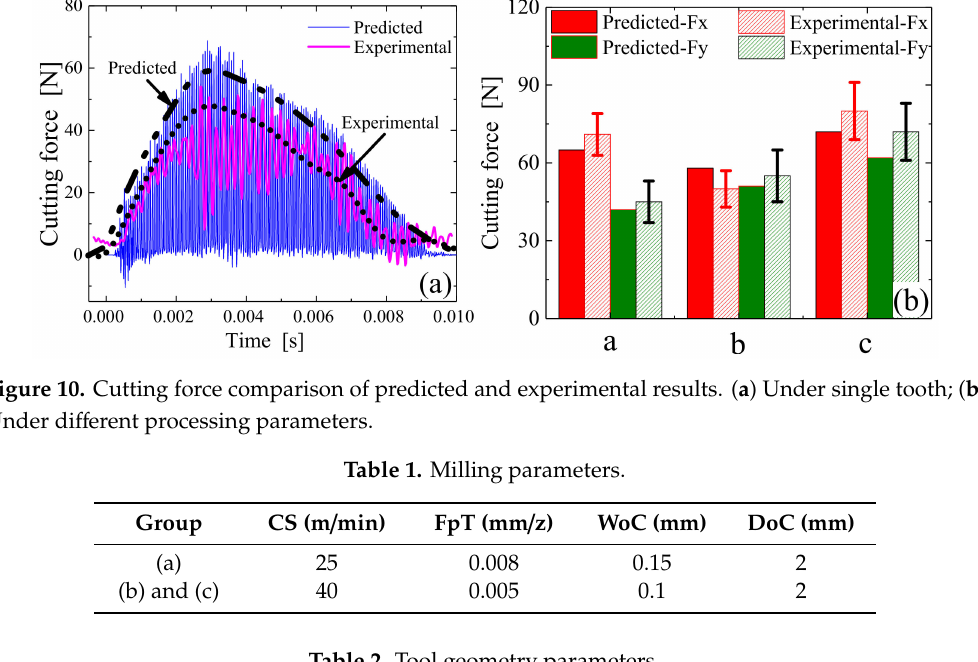
Table 2. Tool geometry